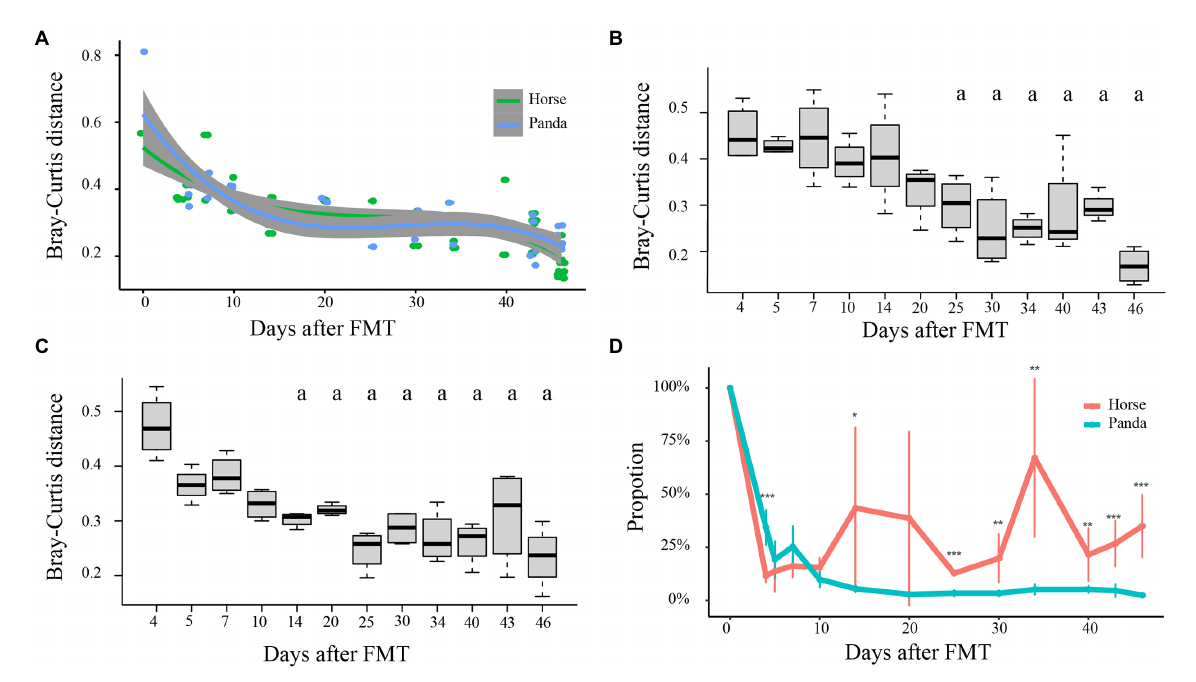
FIGURE 2 The time points of stabilization of the mice gut microbiota after FMT. Bray-Curtis distances of gut microbiota between samples taken at each time point after FMT and the median of corresponding donor samples at the last time point are shown in (A) . The statistical analysis of the Bray-Curtis distances of horse-mice between each time point and the median at the last time point after FMT is shown in (B) and that of panda-mice in (C) . Letter “a” in panels (B) and (C) indicated no significant difference with the last time point. Significance test for panels (B) and (C) was performed by applying the One-way ANOVA with post-hoc Tukey’s HSD (Honestly Significant Difference) by “glht” function in “multcomp” package. t -test was used for panel (D) (* p < 0.05, ** p < 0.01, *** p < 0.001). The results of source tracking analysis are shown in (D) and the proportion of the microbial community composition from the original horse or panda feces changed with days after the original microbial community colonized into corresponding horse-mice or panda-mice. Only at the 5 th , 7 th , 10 th or 20 th day, the retention proportions of the original donor microbial community composition were not significant between horse-mice and